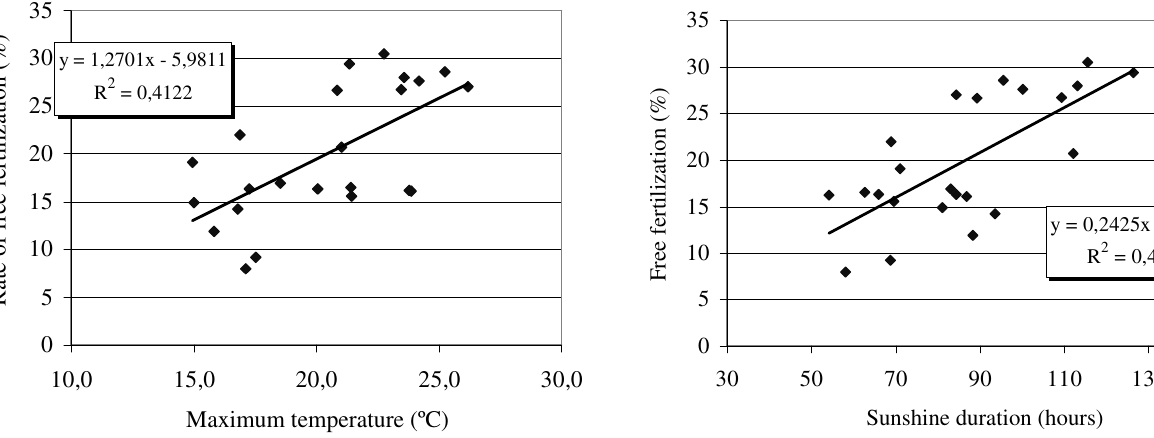
Figure 2: Relationship between free fertilization and average maximum temperature of blooming period at “Újfehértó fürtös” sour cherry cultivar